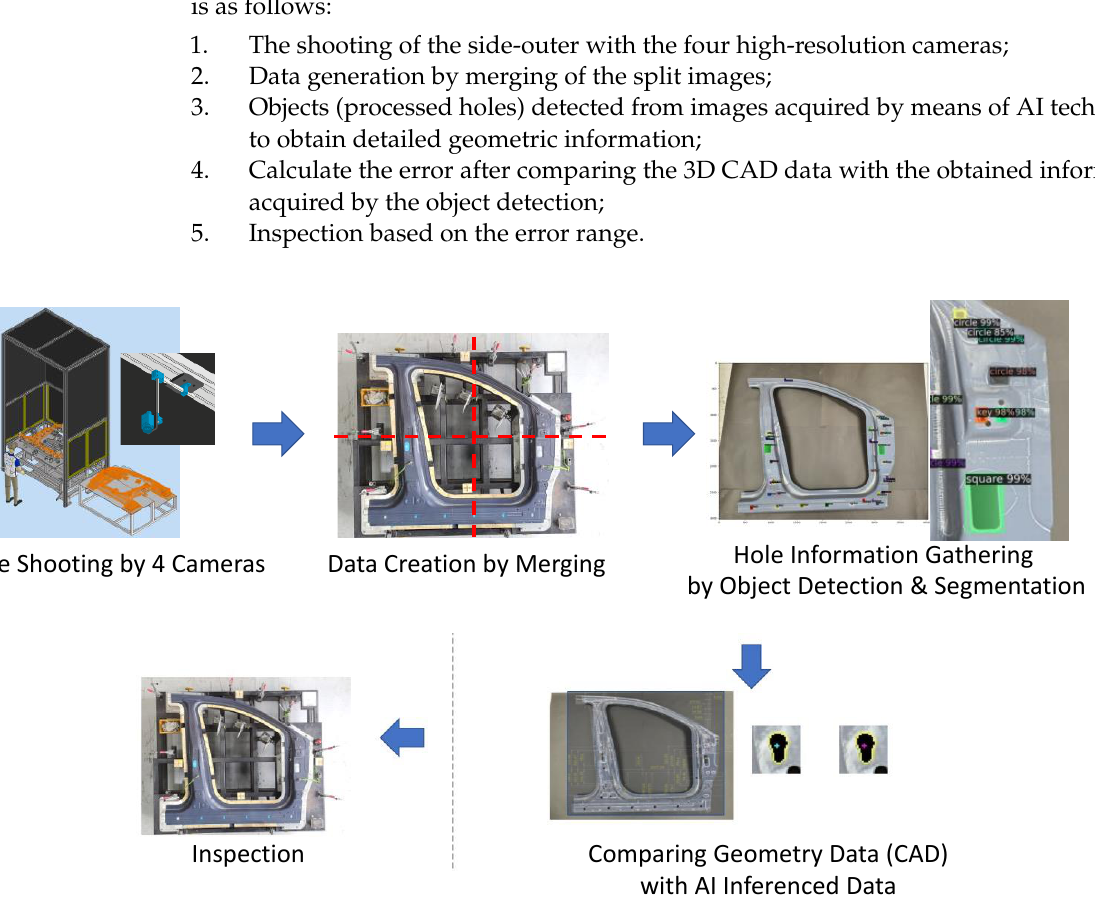
Figure 2. RODIS inspection workflow.